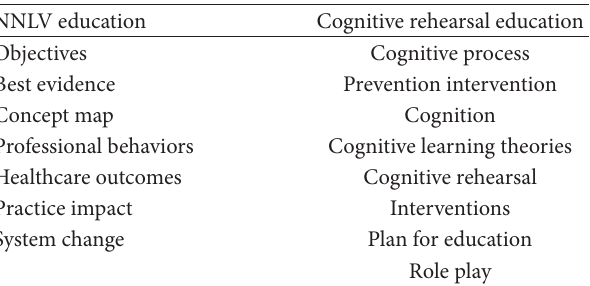
Table 1: Nurse-to-nurse lateral violence education and cognitive rehearsal